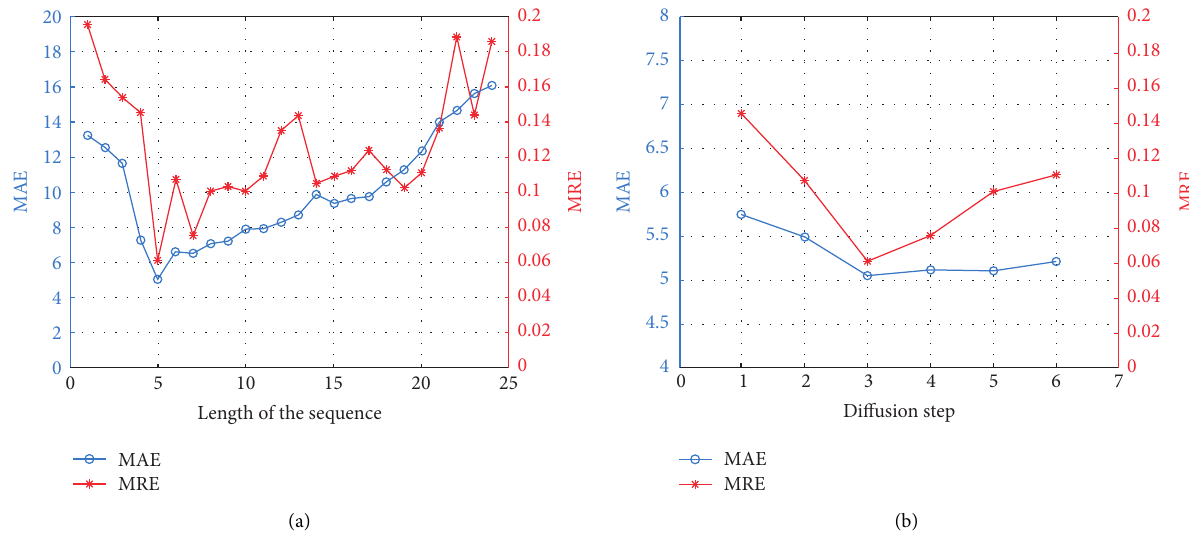
Figure 5: Sensitivity analysis of input sequence length and diffusion step length.